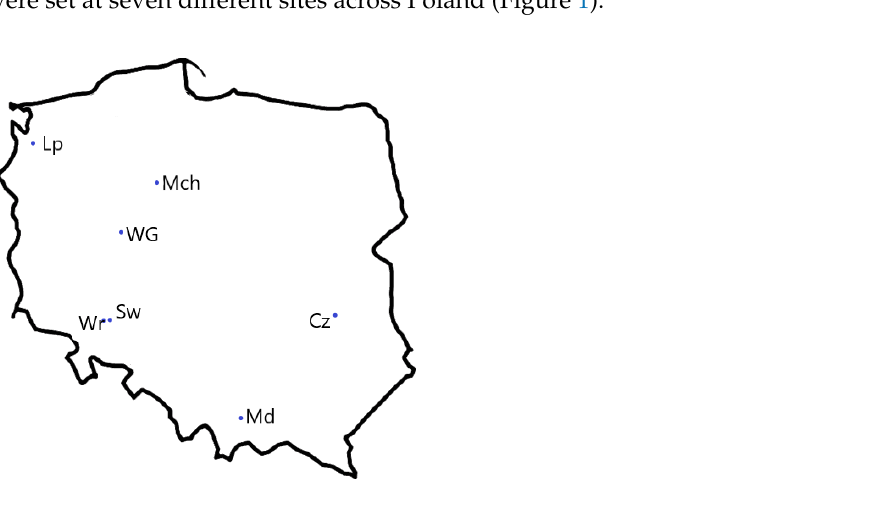
Figure 1. Distribution of the study sites. Lp—Lipnik; Mch—Moche ł ek; WG—Winna Góra; Cz—Czesławice; Sw—Swojczyce; Wr—Wrocław; Md—Mydlniki.